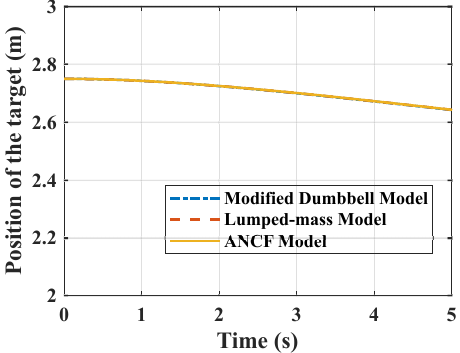
Figure 10. Position of the mass center of the target.